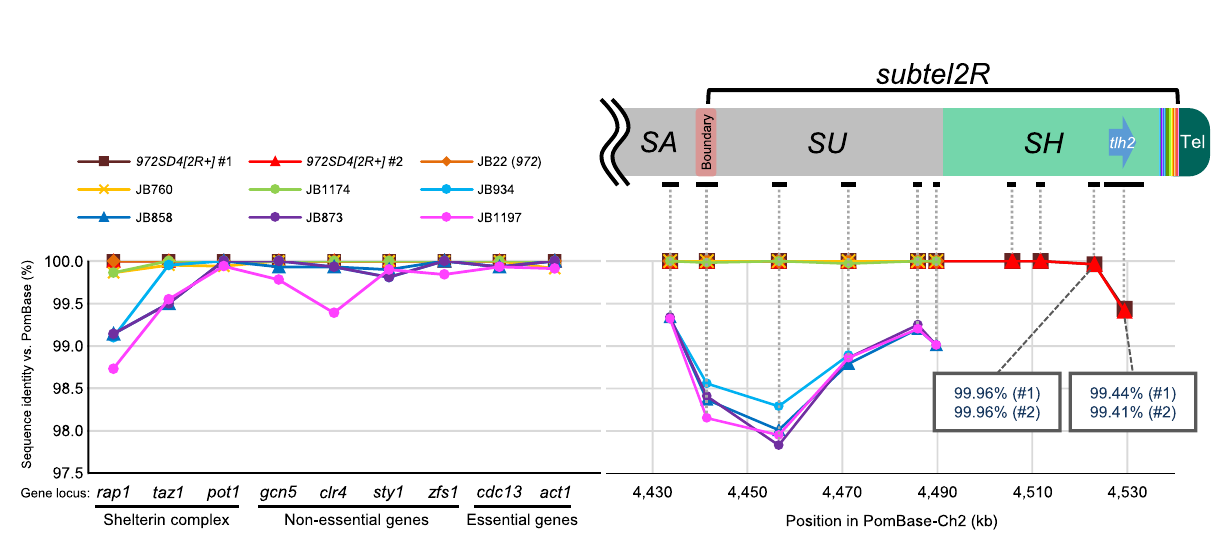
Fig. 7 Subtelomeres are hot spots for sequence variation. Sequence identities between PomBase- 972 and other S. pombe strains used in this study. Sequences of the SH-D and SU regions, the subtelomere boundary, and the SA region in Ch2R , and those of other gene loci of three categories were analyzed (see Supplementary Table 2 for the details). Note that two independent 972SD4[2R + ] strains (clones #1 and #2) contain different sequences around the tlh2 gene